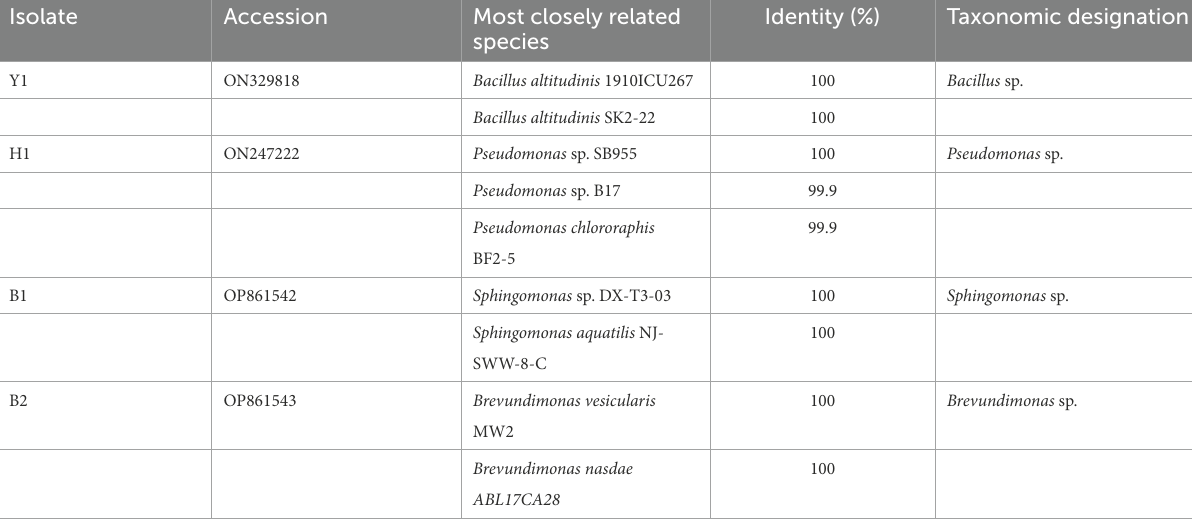
TABLE 1 Identification of bacterial isolates based on 16S rRNA gene in NCBI.